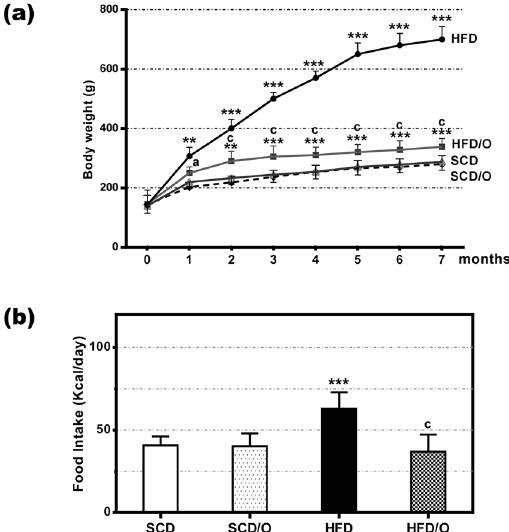
Figure 1. Effect of omentectomy on body weight and food intake, in rats fed a HFD. ( a ) Evolution of body weight in groups 1–4. SCD, rats on a standard chow diet that underwent sham surgery after the acclimatization period (at the age of six weeks); SCD/O, rats on a standard chow diet that underwent omentectomy after the acclimatization period; HFD, rats on a high fat diet. They underwent sham surgery after the acclimatization period; HFD/O, rats on a HFD. These rats underwent omentectomy after the acclimatization period; ( b ) Food intake by the groups 1–4 of rats. This intake was measured at the end of the experimental period. Statistical differences between groups were analyzed by two-way ANOVA. ** p < 0.01; *** p < 0.001 effect of diet; ( a ), p < 0.05; ( c ), p < 0.001 effect of